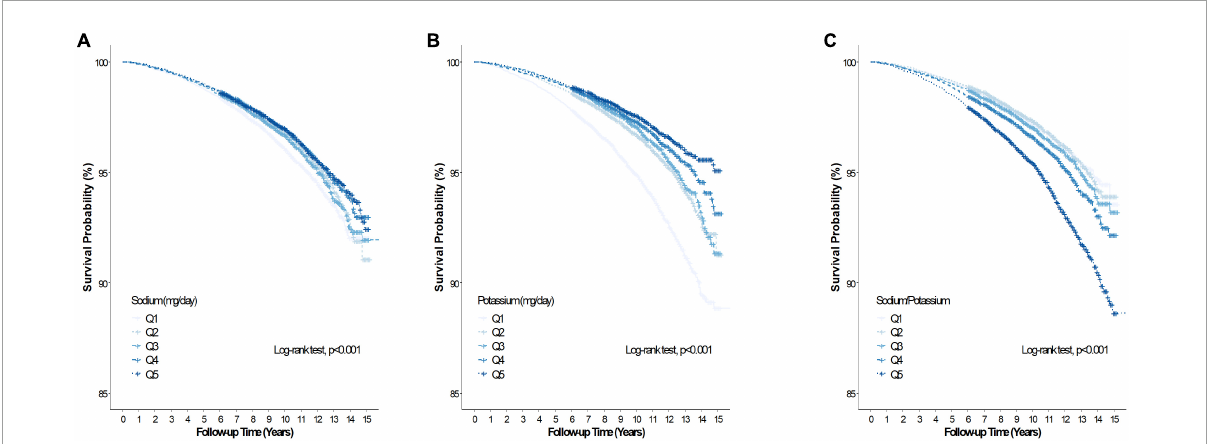
FIGURE2 Kaplan–Meier curve of the association between salt intake and all-cause. (A) Association between dietary sodium (Na) and all-cause mortality. (B) Association between dietary potassium (K) and all-cause mortality. (C) Association between dietary sodium-to-potassium (Na/K) ratio and all-cause mortality.